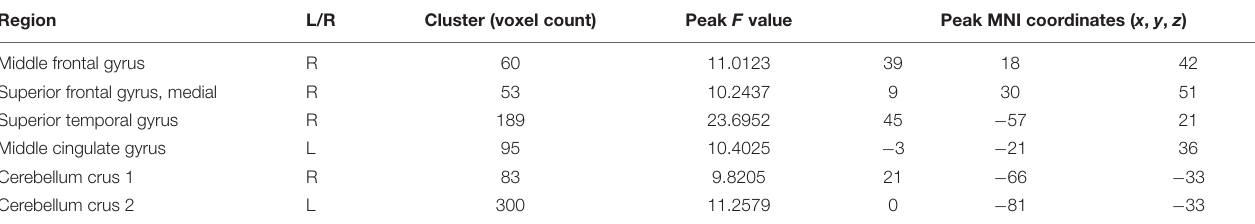
TABLE 2 | Anatomical locations of regions showing significant differences in functional connectivity from the posterior cingulate cortex among control subjects, early-mild cognitive impairment (MCI) patients, and late-MCI patients. Region L/R Cluster (voxel count) Middle frontal gyrus